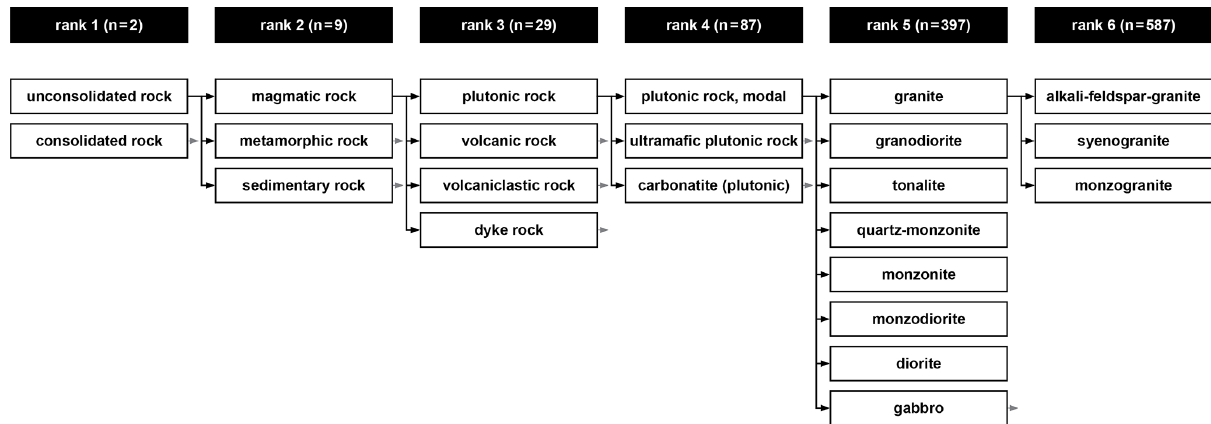
Figure 2. Hierarchical system of standardized petrographic terms referring to Bär et al. (2019). Black boxes show the rank and number of entries within each rank; white boxes represent the specific term and show classification scheme on the example of granites. Black arrows indicate direct connections and grey arrows represent additional terms not displayed here.